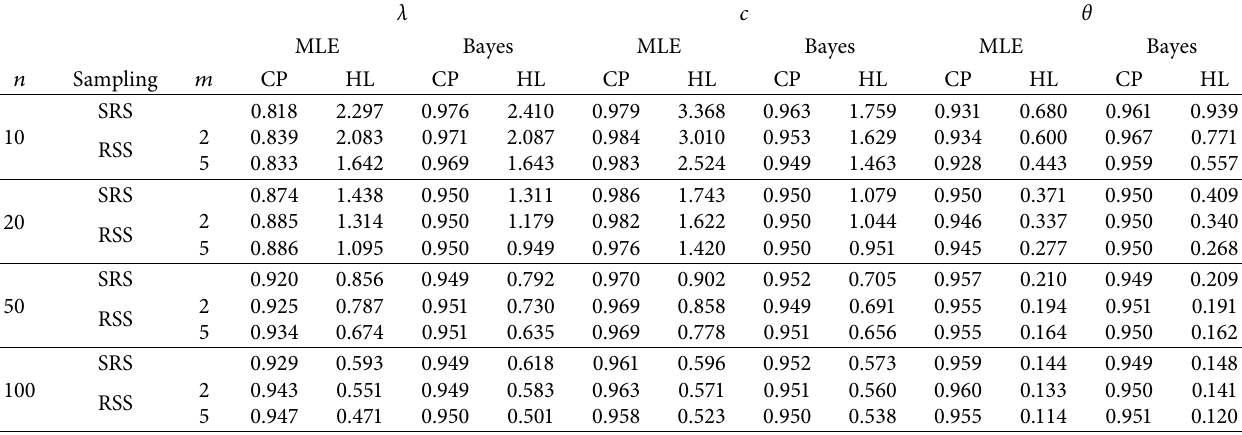
Table 6: Coverage probability (CP) and half length (HL) of the MLE and Bayes estimates under RSS and SRS for different sample sizes and